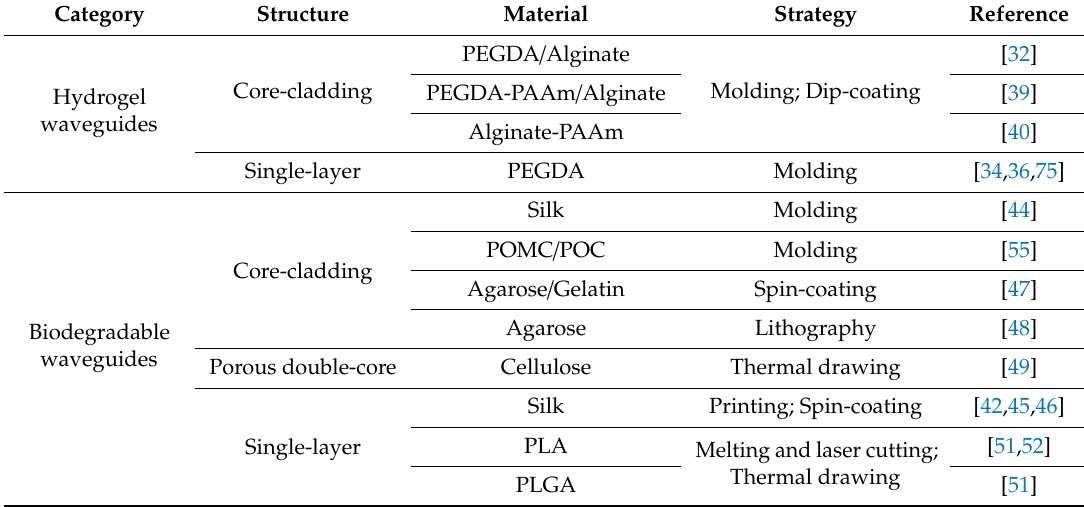
Figure 8. ( a ) Strain-sensitive optical waveguide comprised of a core of polyurethane rubber and the cladding of silicone composite. Reproduced with permission [86]. Copyright 2016, American Association for the Advancement of Science; ( b ) Shaking with a prosthetic hand, integrated with stretchable optical waveguides for strain sensing. Reproduced with permission [86]. Copyright 2016, American Association for the Advancement of Science; ( c ) Schematic illustration of the prosthetic innervated finger integrated with sensory waveguides. Reproduced with permission [86]. Copyright 2016, American Association for the Advancement of Science; ( d ) Smart glove. Stretchable core-cladding optical fibers made from thermoplastic elastomers were installed on each finger of a glove to track the finger movements, enabling real-time control of a virtual hand model. Reproduced with permission [68]. Copyright 2018, Wiley; ( e , f ) Stretchable sensory fiber integrated with an LED and a photodiode to track the knee angle. Reproduced with permission [68]. Copyright 2018, Wiley. Table 1. Representative polymeric materials and strategies for waveguide fabrication.